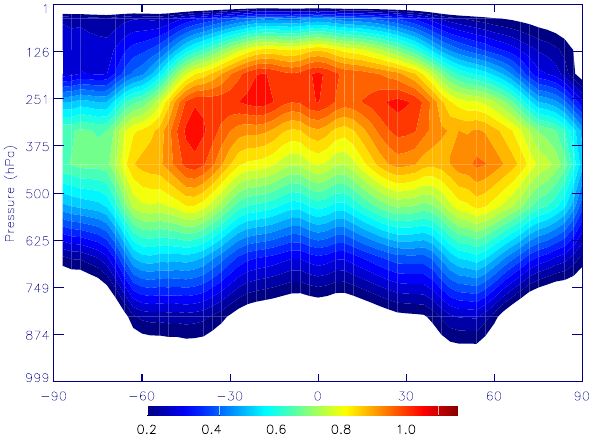
Fig. 5. Zonal mean of the area of averaging kernels. The x axis is the latitude. The color bar represents the value of the area of the averaging kernels (no unit).